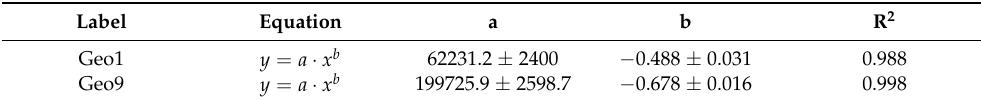
Figure 6. Calibration − Fit for Geo1 and Geo9 with statistical consideration. The impedance measure- ments were made at 8 MHz. The fitting parameter for the asymptotic-fit are shown in Table 4. Table 4. Fitting Parameter for fit Geo1 and